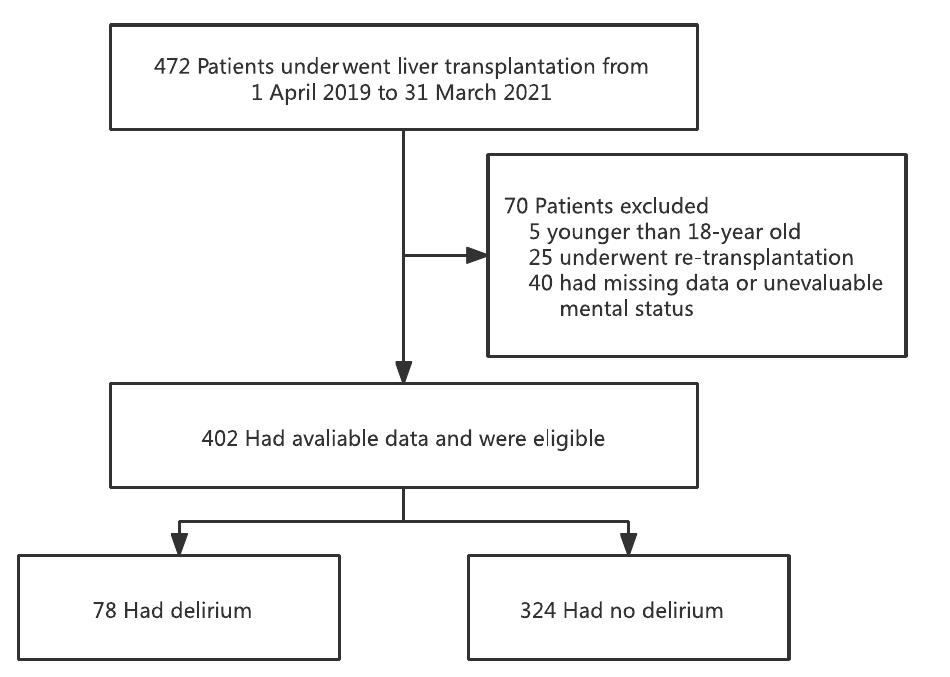
Figure 1. Flowchart analyzing the effect of preoperative total bilirubin on postoperative delirium after liver transplantation.